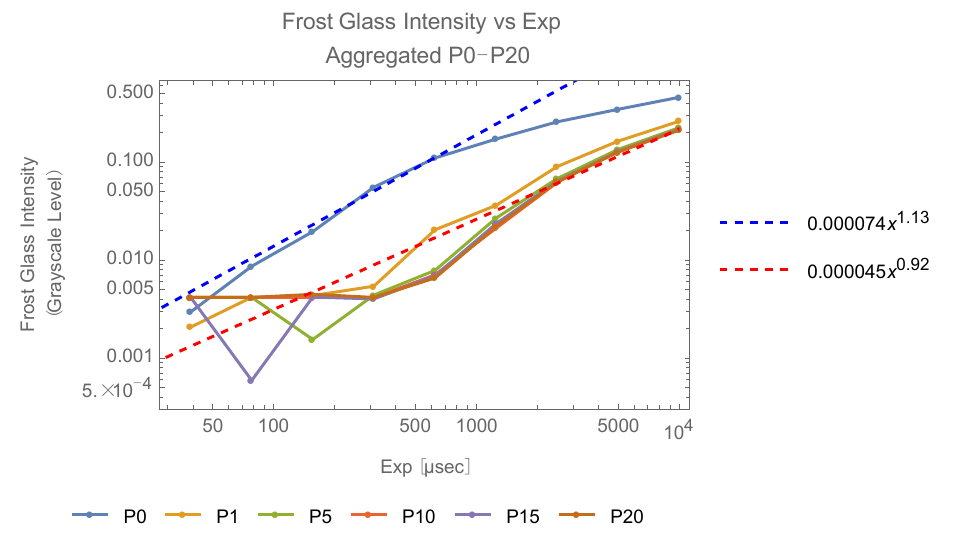
Figure A1. Grayscale level dependence on exposure time. Even though grayscale level differs nearly 10 times between P0 and P1, P5, P10, P15 and P20, each estimation of the γ parameter using data from each plot’s linear region is close to one. Therefore, γ parameter correction is not applied in the following data anal- ysis.